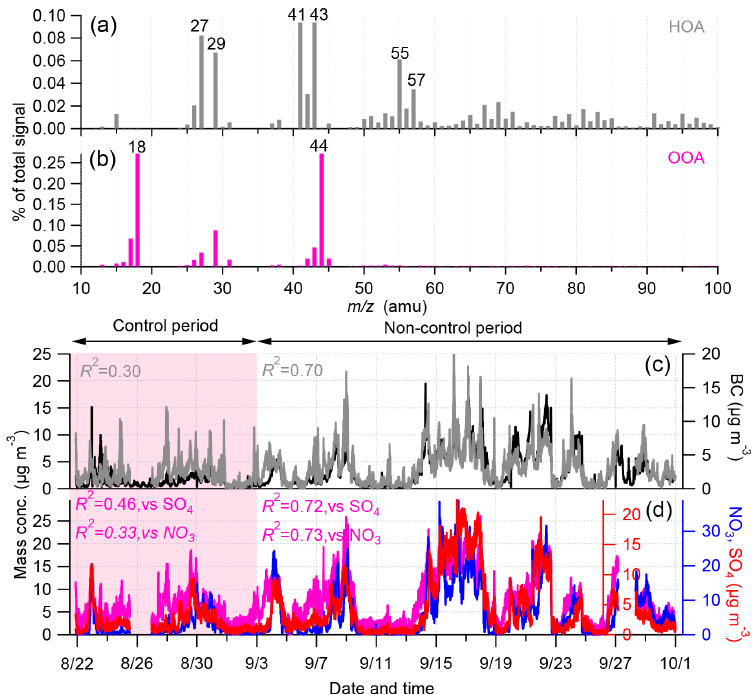
Figure 4. Mass spectral profiles and time series of (a, c) hydrocarbon-like OA (HOA) and (b, d) oxygenated OA (OOA) at 260m. Also shown are the time series of BC, sulfate and nitrate for comparisons. The correlation coefficients ( R 2 ) between OA factors and external tracers during control (pink area) and non-control periods are also given in panels (c) and (d)